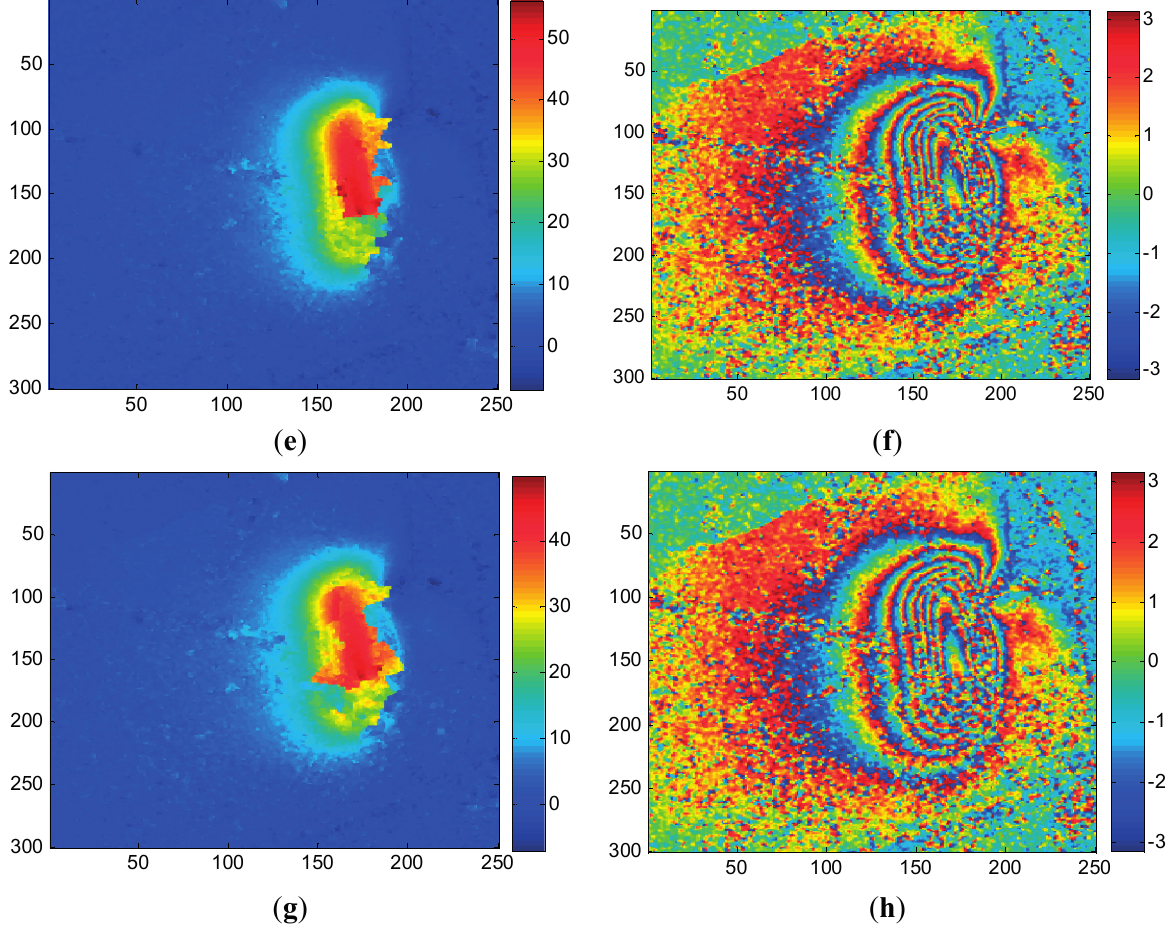
Figure 7. Experimental results for Dataset 2: ( a ) original differential interferogram; ( b ) corresponding coherence map; ( c ) unwrapped map of CKFPU; ( d ) rewrapped map of CKFPU; ( e ) unwrapped map of MCF when the pre-filtering threshold is set at 0.1; ( f ) rewrapped map of (e); ( g ) unwrapped map of MCF based on MCF when the pre-filtering threshold is set at 0.25 and ( h ) its rewrapped